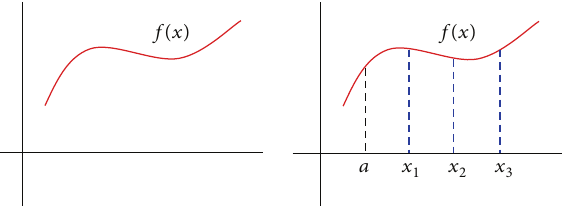
Figure 5: Task parallelization and job distribution among Hadoop clusters.